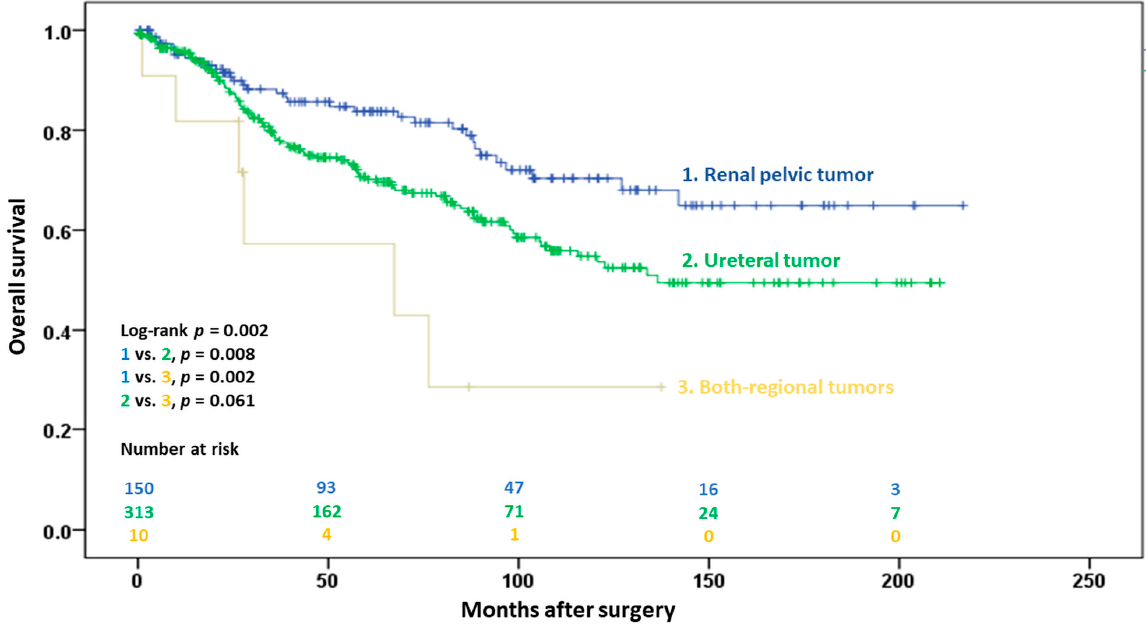
Figure 4. Kaplan–Meier estimates of overall survival in 476 patients following radical surgery for pT2 upper urinary tract urothelial carcinoma, with stratification by tumor